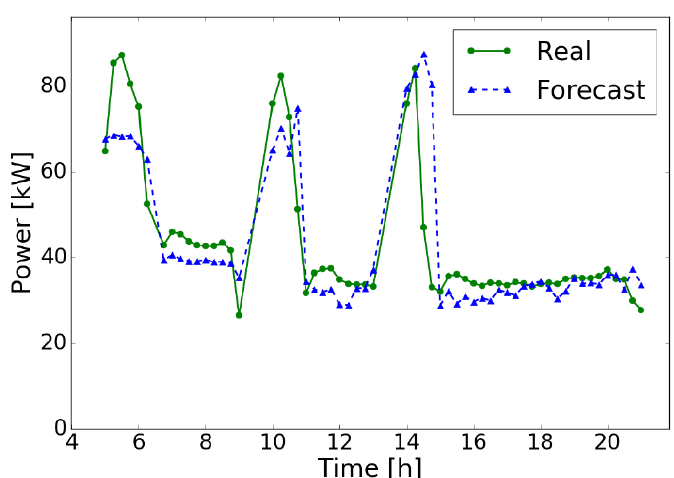
Figure 8. Daily 15 min average power prediction for a triple-cycles building with 1-h advance (5% maximum error on weather forecast).